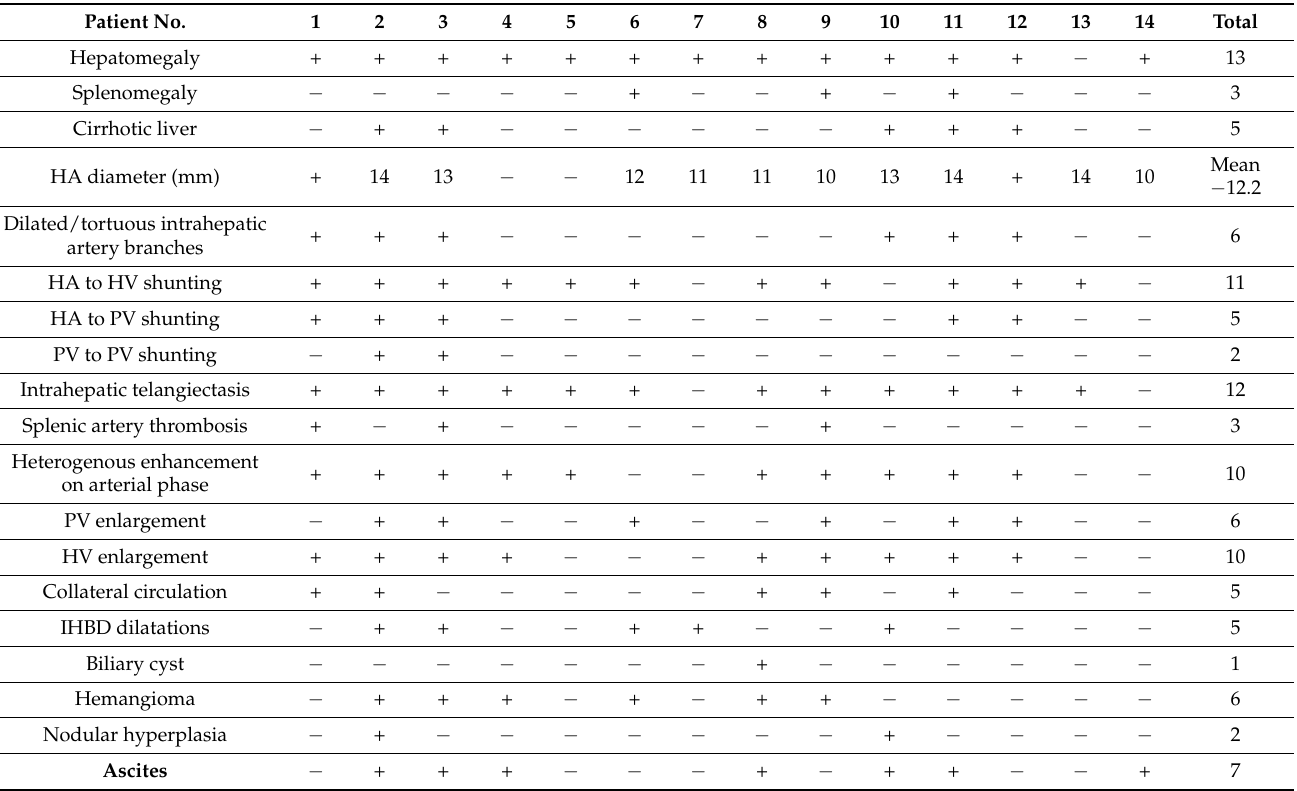
Table 3. The abdominal involvement for each patient with Osler–Weber–Rendu disease.